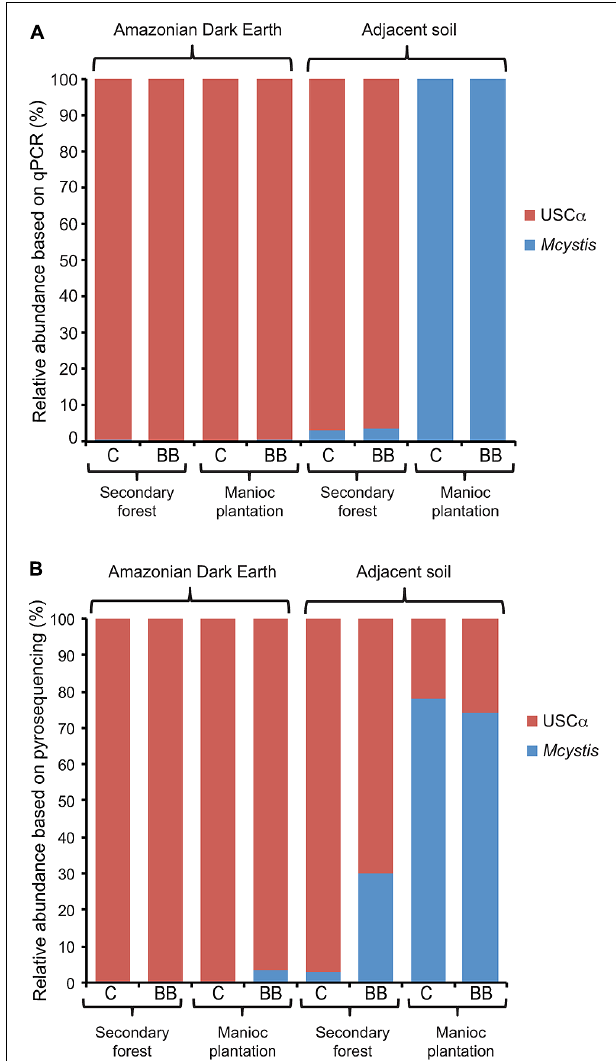
FIGURE 4 | Relative abundance of Methylocystis ( Mcystis ) and USC α pmoA genes inAmazonian Dark Earth and their adjacent soils under secondary forest and manioc cultivation at Barro Branco (BB) and Caldeirão (C) sites. Abundances calculated based on (A) qPCR or (B) pyrosequencing